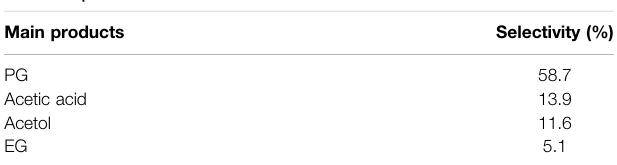
TABLE 1 | Reactions of CTH